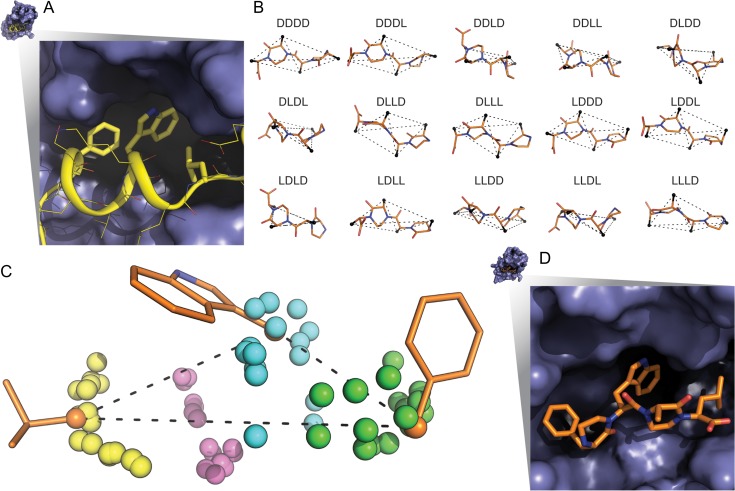
(A) The P53 (yellow) and MDM2 (blue) interface showing phenylalanine, tryptophan and leucine hotspot residues. (B) Fifteen of the 16 OOP backbone scaffolds fit to hotspot residue stubs. Scaffolds combinatorically sample the l or d enantiomers of the four residues that comprise the OOP scaffold. Each backbone has four Cβ atoms (black spheres) and thus four possibly matching triangles indicated by dashed lines. (C) The P53 hotspot residue stubs (orange). In this work, each hotspot residue has two χ dihedral angles resulting in a single fixed Cβ (orange spheres) triangle (dashed lines). Hotspot residues with additional χ angles would produce multiple triangles. Colored spheres show potential Cβ atoms from the OOP scaffolds for the first (green), second (cyan), third (magenta), fourth (yellow) residues in the scaffold. (D) The LLLL-OOP scaffold (orange) designed by Drew and coworkers and correctly identified by the algorithm bound to MDM2 (blue).